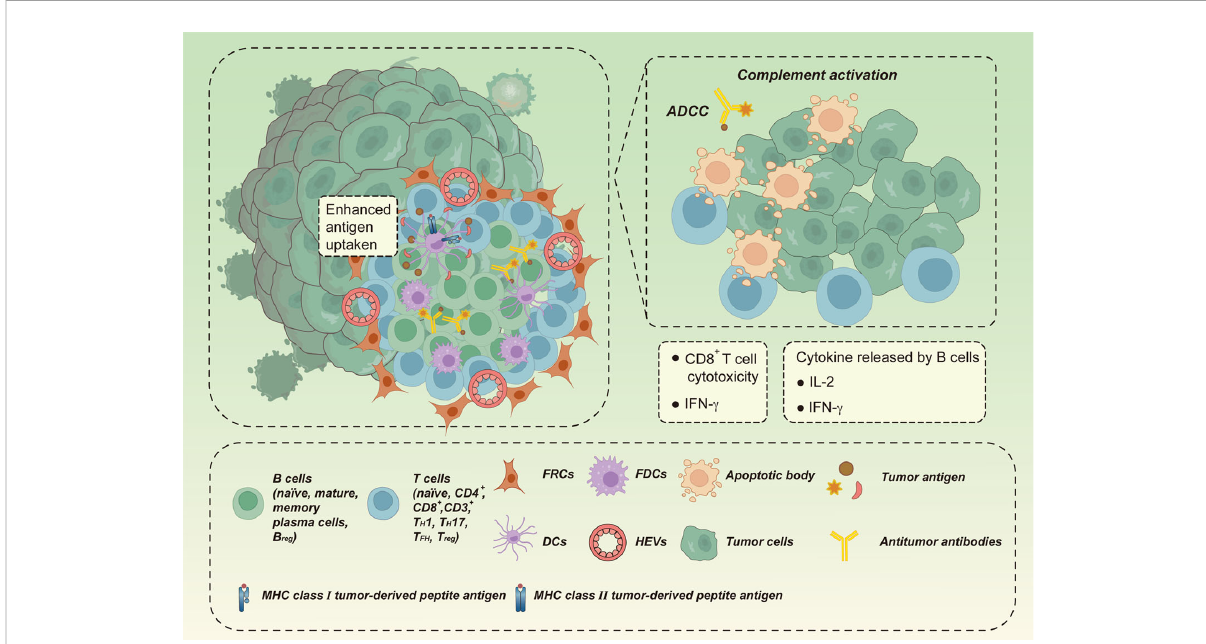
FIGURE 2 The antitumor effect of TLSs. TLSs may enhance local immune responses at the site of tumor-associated TLS (TA-TLS) formation by B cells directing T cells to recognize tumor-associated antigens (TAAs) to clear infection or kill tumors. B cells may trigger T cell initiation by presenting captured TAAs directly to T cells via B cell receptors. B cells may also produce antibodies against TAAs locally by acting in coordination with CD8 + cytotoxic effector T cells. Tumors are eliminated in situ through direct killing of tumor cells, antibody-dependent cytotoxicity (ADCC) mediated by macrophages and/or natural killer cells, and local complement activation. In addition, B cells can drive cytotoxic immune responses by releasing cytokines (e.g., IFN- g and IL-12), thus promoting antitumor